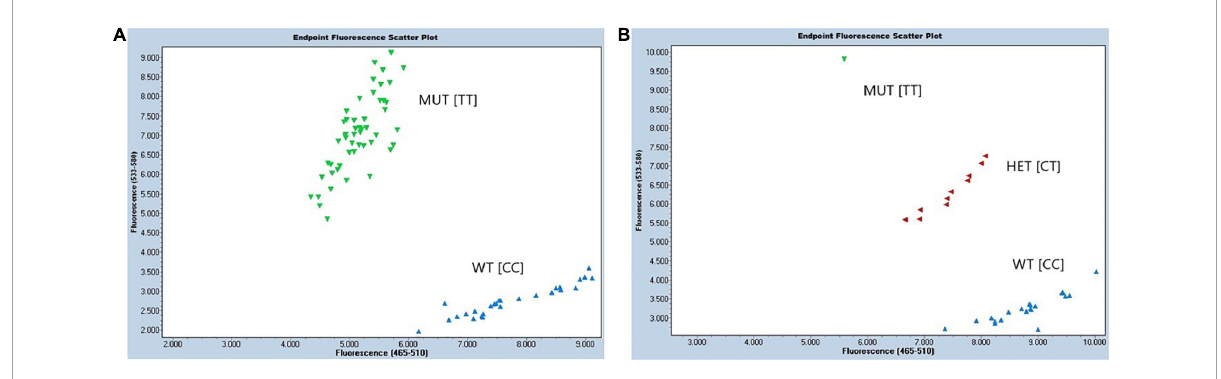
FIGURE6 Performance of developed KASP assay ED-5 for detection of protein QTL on chr.14. Endpoint fluorescence scattering plots of (A) RHD-NIL population, and (B) BC 1 F 1 breeding population. Allele-specific HEX primer (mutant; MUT) was displayed in green, allele-specific FAM primer (wild type; WT) was displayed in blue, and heterozygous (HET) lines were marked in red. The X -axis displays fluorescence of FAM at 523–568 nm, and the Y -axis displays fluorescence of HEX at 483–533 nm. Molecular marker assay for Gm14_8059955 is displayed above containing the forward FAM allele X wild type (WT), forward HEX allele Y mutant (MUT), and the reverse